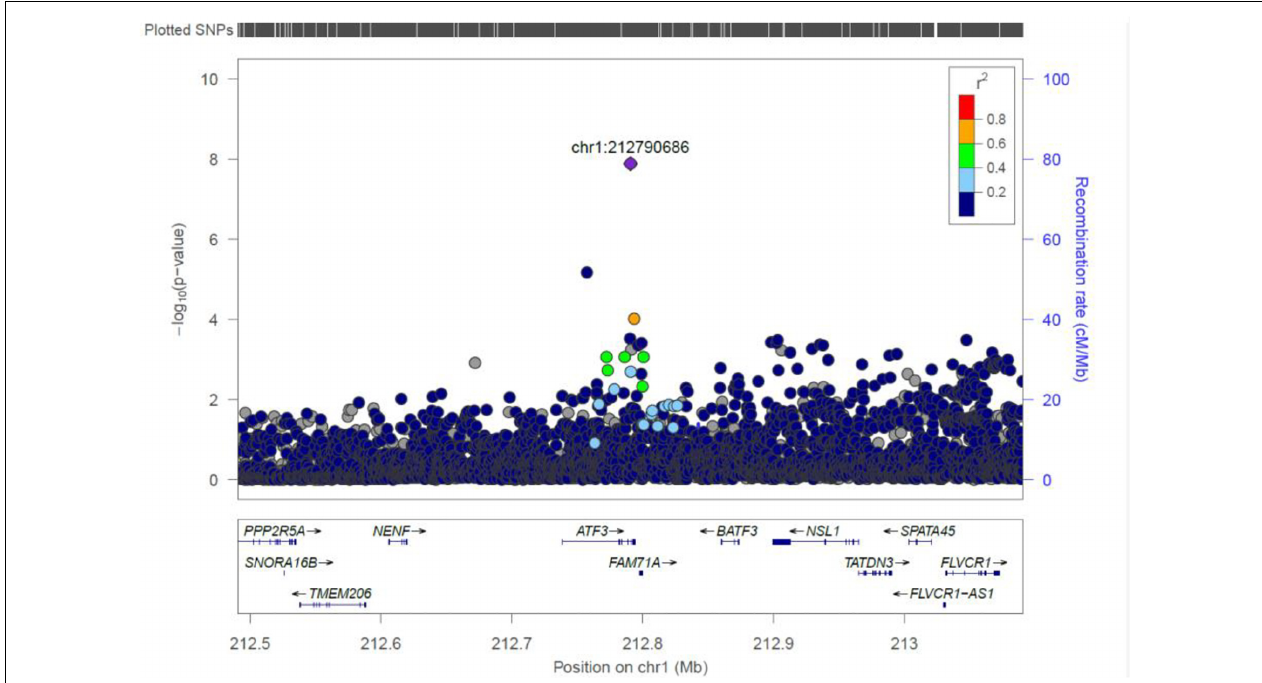
FIGURE 5 | Regional visualization of the GWAS of –log10 of the P -value of genomic location ATF3 (rs3123543 in purple), with each dot representing a SNP on the corresponding genes at the bottom.